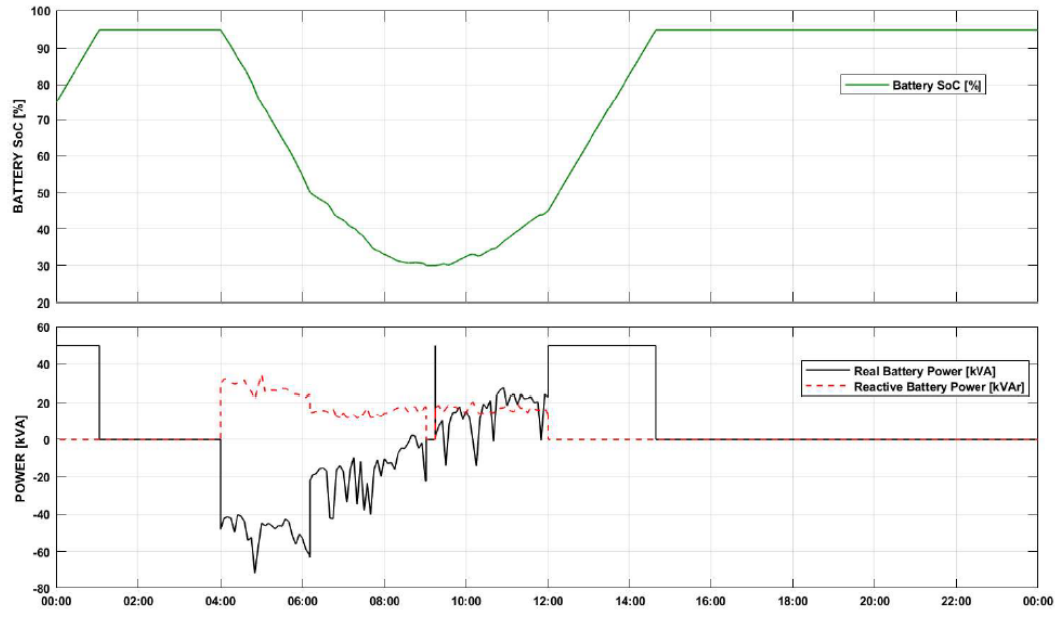
Figure 15. Performance of 250 kWh BESS during an 8 h power cut.